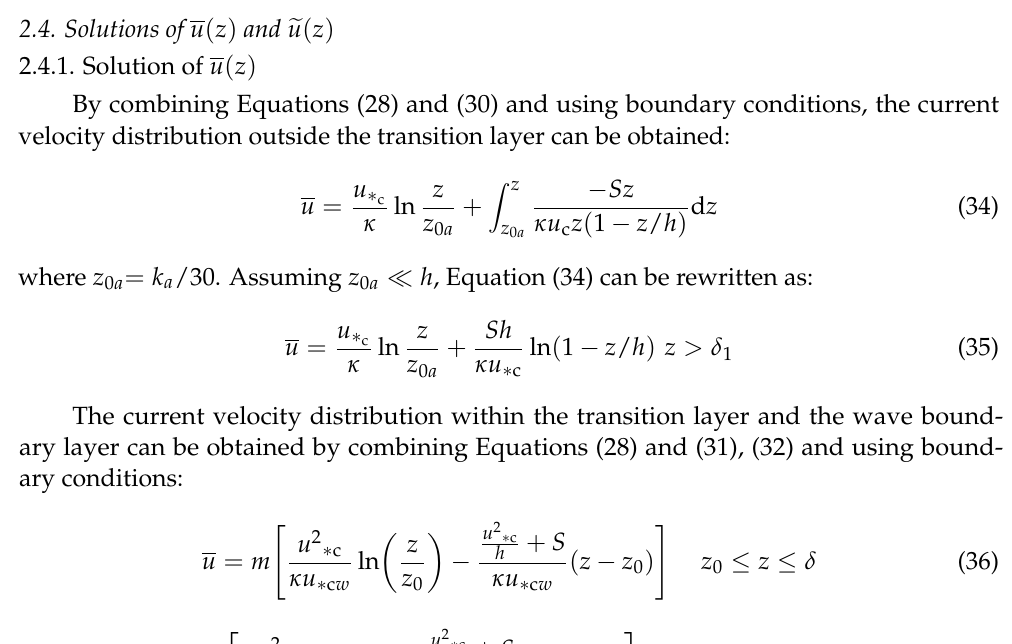
Figure 2. The distributions of the eddy viscosities ( a ) Wave eddy viscosity; ( b ) Current eddy viscosity.